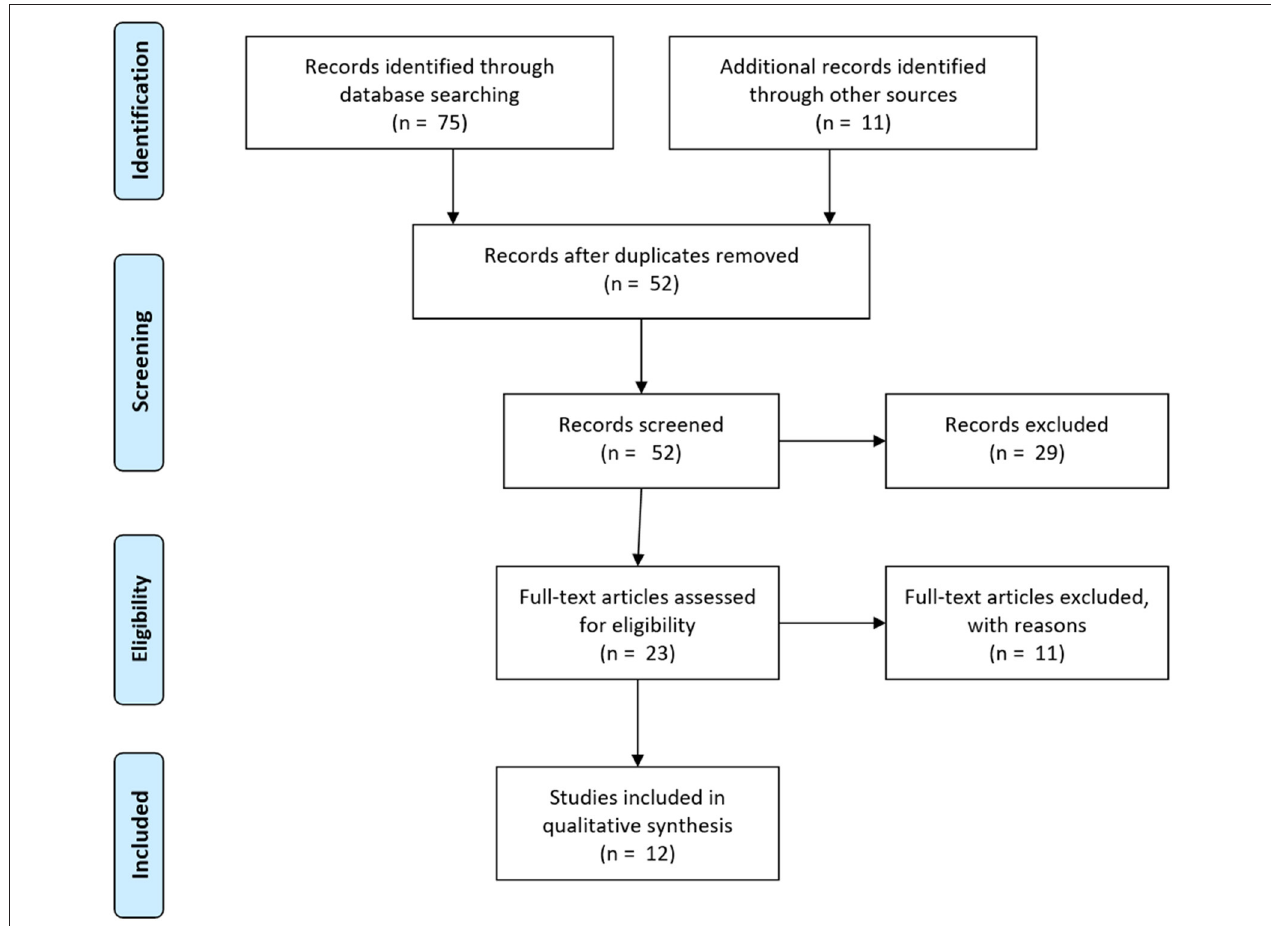
FIGURE 1 | PRISMA 2009 flow diagram of the study selection process (adapted from Moher et al.,